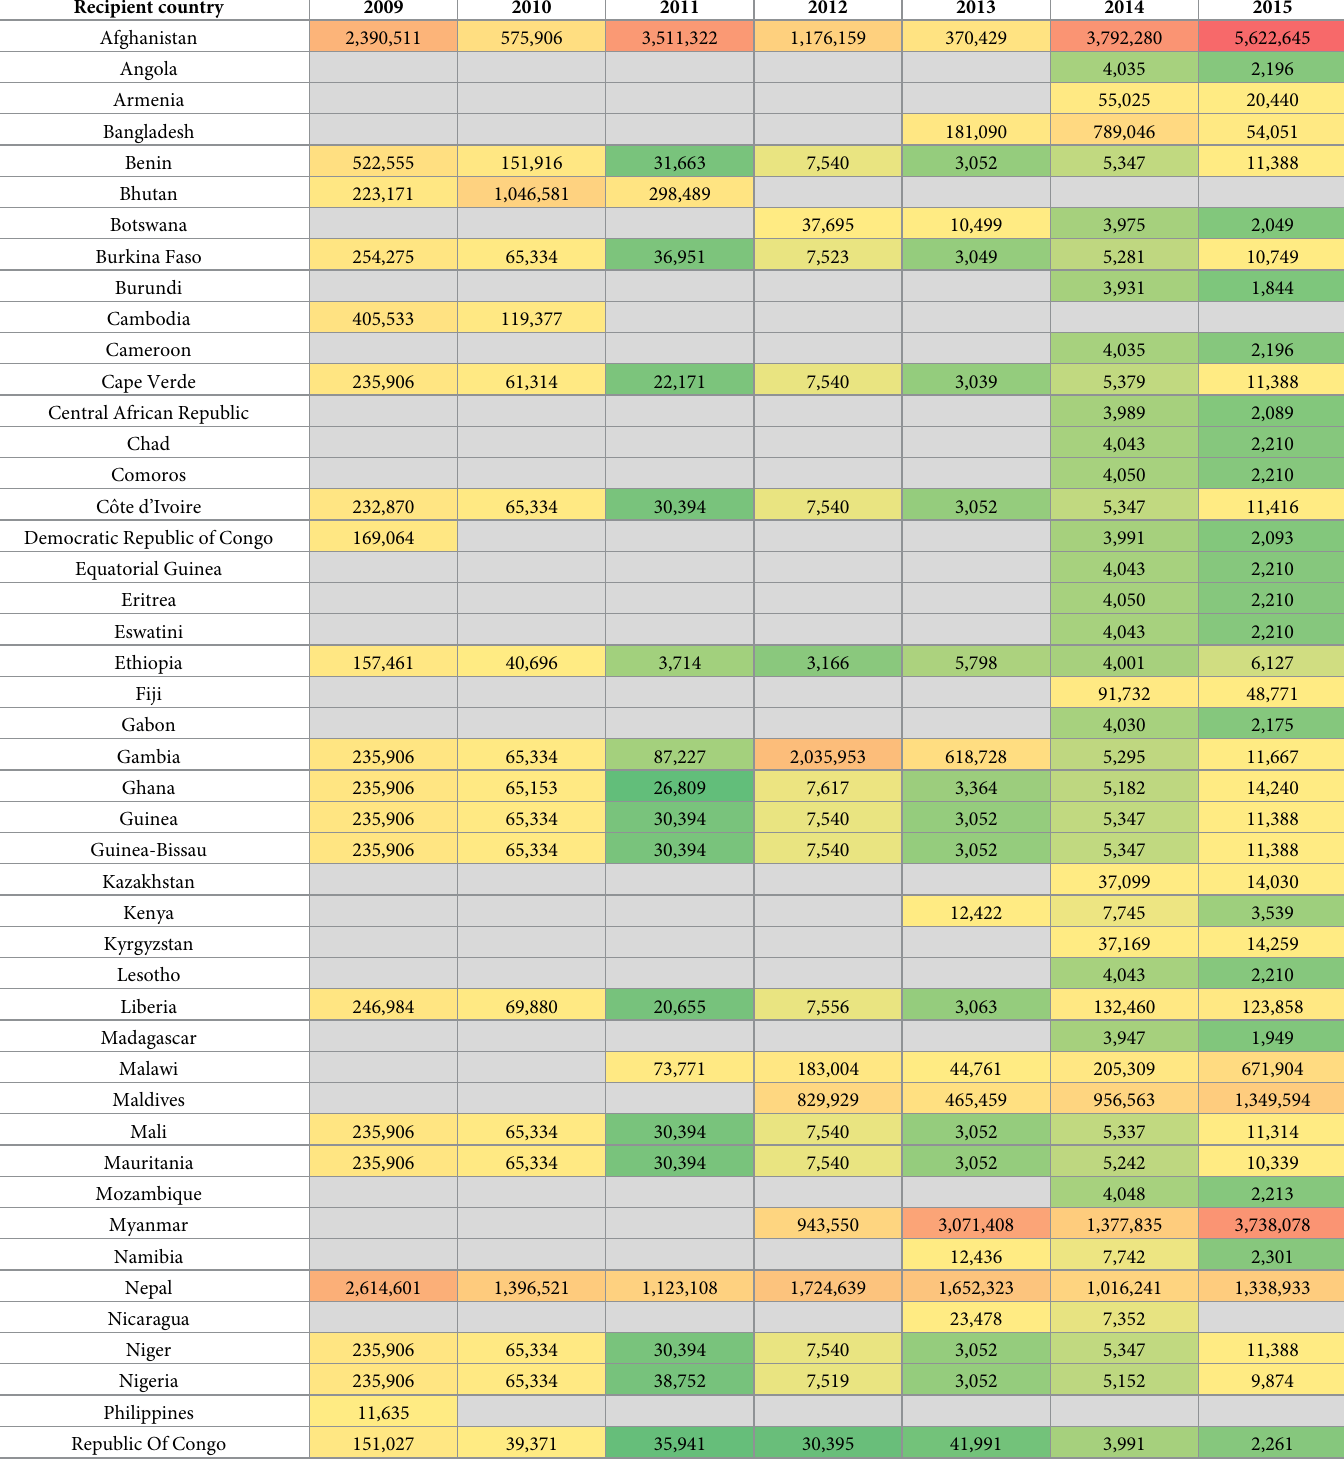
Table 3. Estimated annual DAH (USD) contributed from by India disaggregated by year and select recipient country (2009–2015). Red and green represent high and low contributions to the recipient country, respectively. Recipient